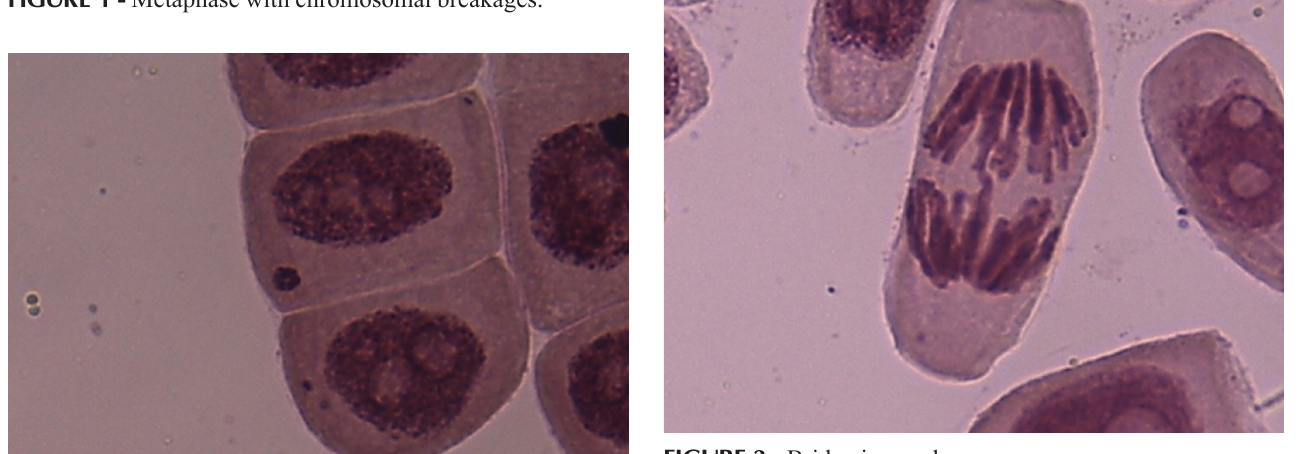
FIGURE 3 - Bridge in